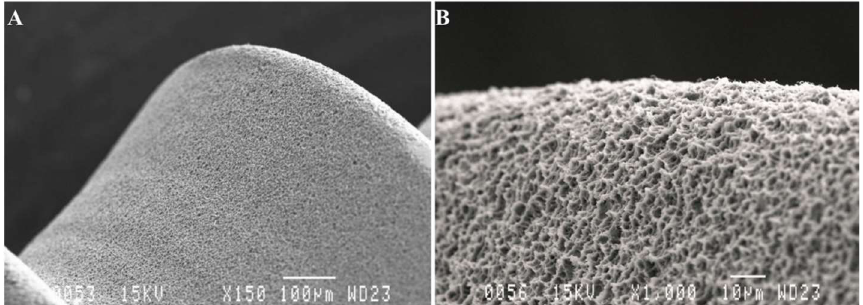
Figure 2. ( A ) SEM images provided by the manufacturer of the Avantblast ® surface (Phibo ® Dental Scheme 150 magnification); ( B ) Surface details X1000 magnification.